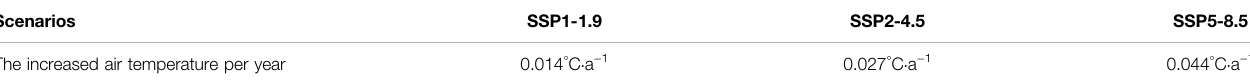
TABLE 5 | The increased air temperature per year.